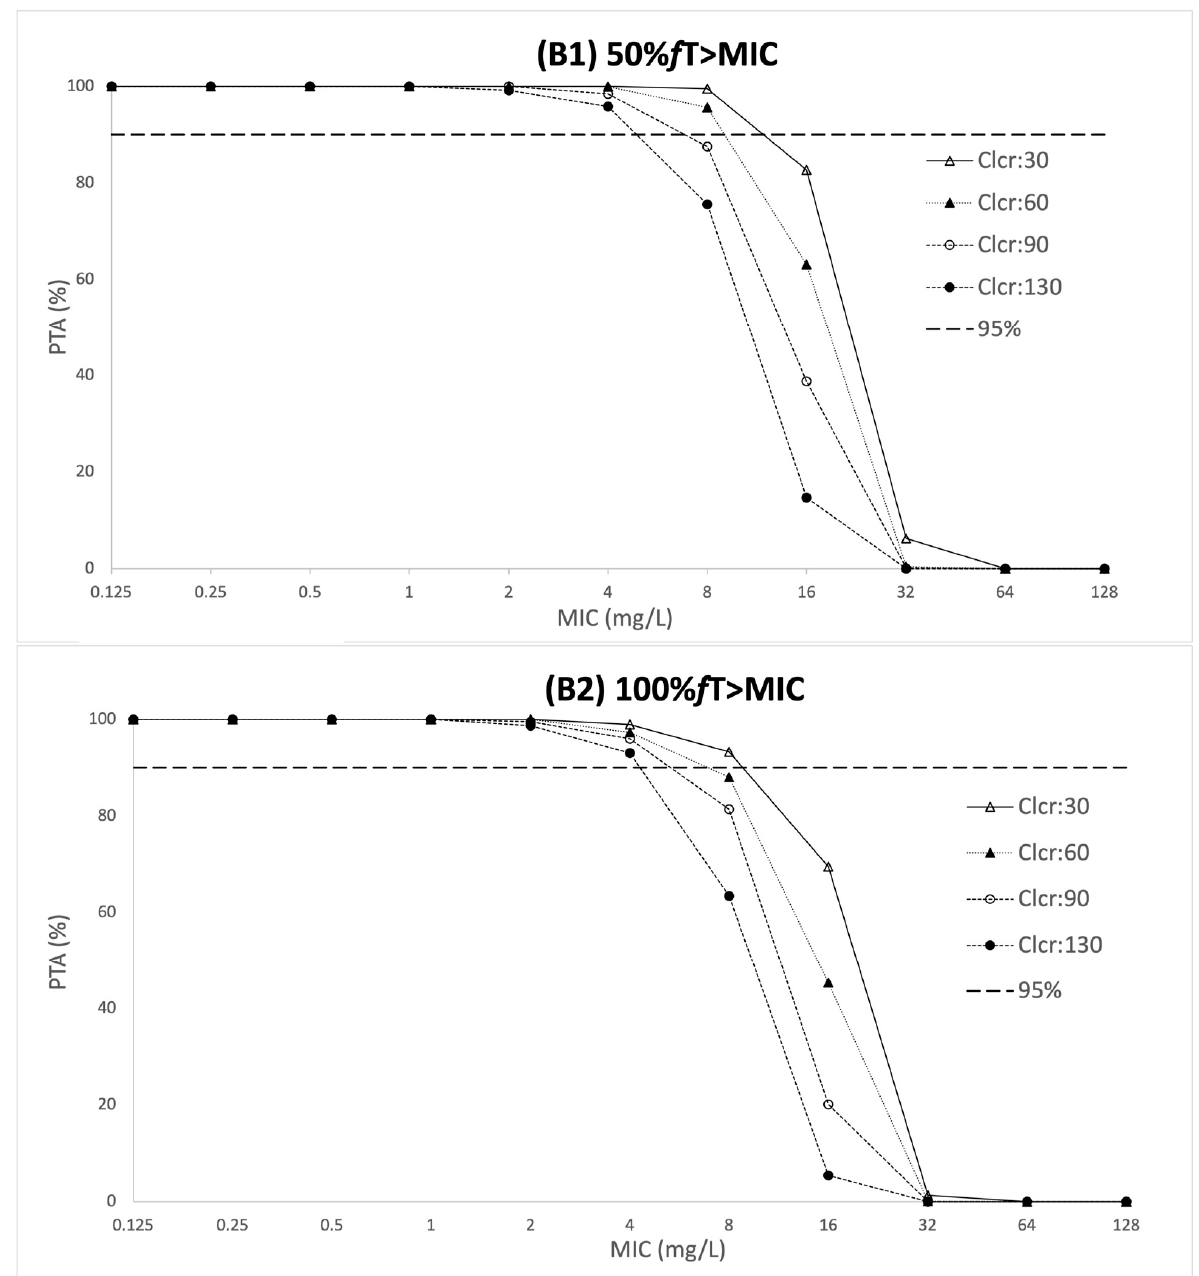
Figure 2. Probability of target attainment (50% f T > MIC and 100% f T > MIC) for conventional piperacillin intermittent dosing regimen: ( A ) 4 g 8-hourly, ( B ) 4g 6-hourly and intermittent infusion of 0.5 h. CLcr, creatinine clearance in mL/min/1.73 m 2